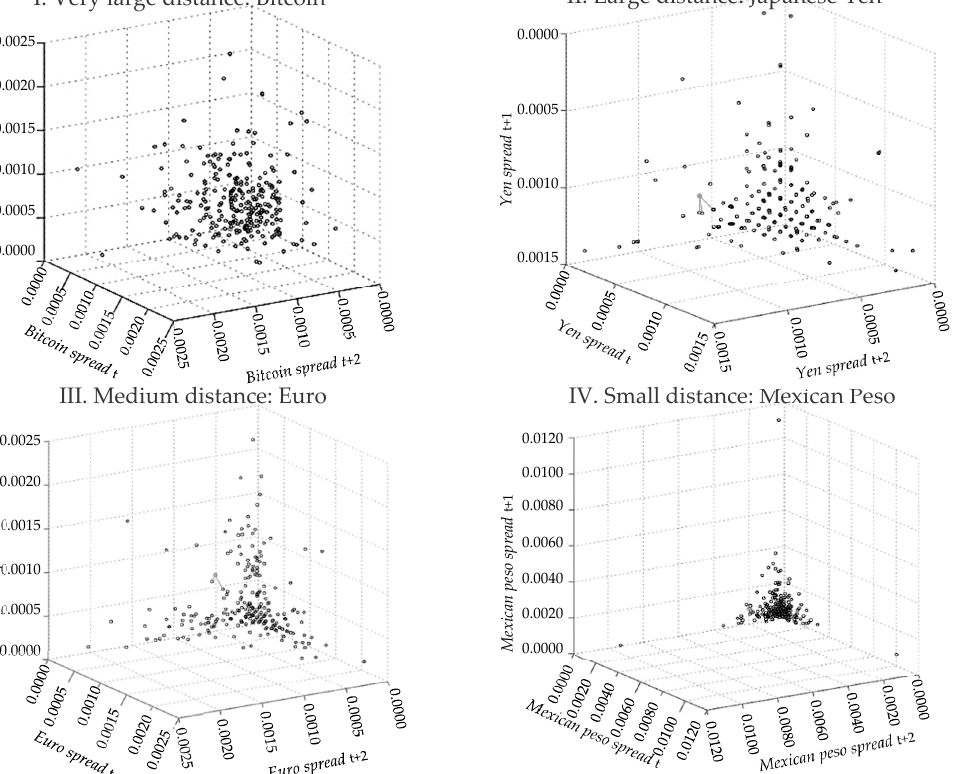
Figure 1. Dispersion points in the predictor space chart for the k-nearest neighbor (KNN) approach. Source: Own elaboration with SPSS 21 from Bloomberg data. Table 5. Nearest neighbor predictions for 6 February 2019.